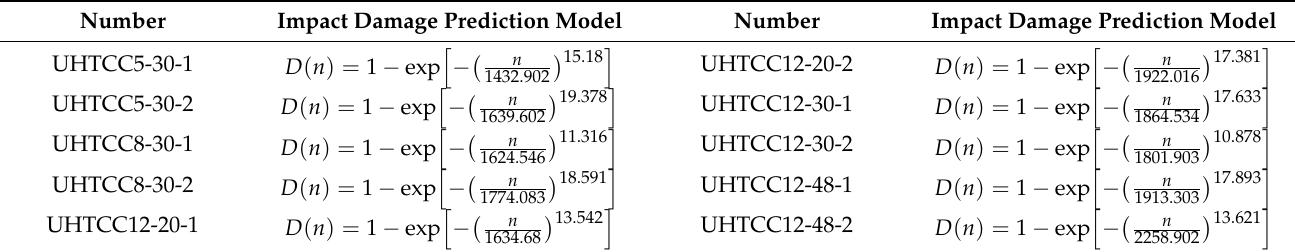
Table 12. UHTCC Weibull distribution model for impact damage